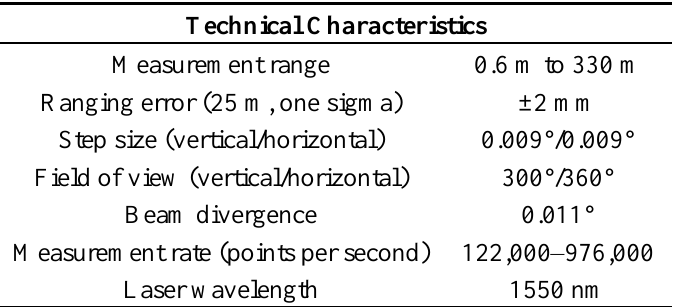
Table 1. Technical characteristics of the FARO Focus3D X 330 laser scanning device according to the manufacturer datasheet.